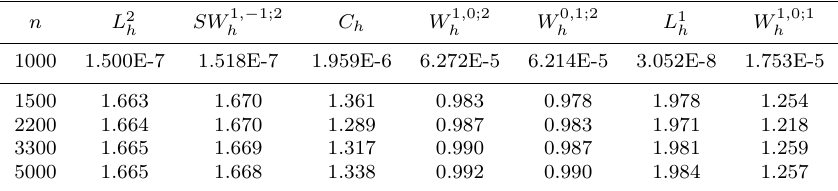
Table 20. Practical errors and error orders in Example C 1 / 2 , 1 n